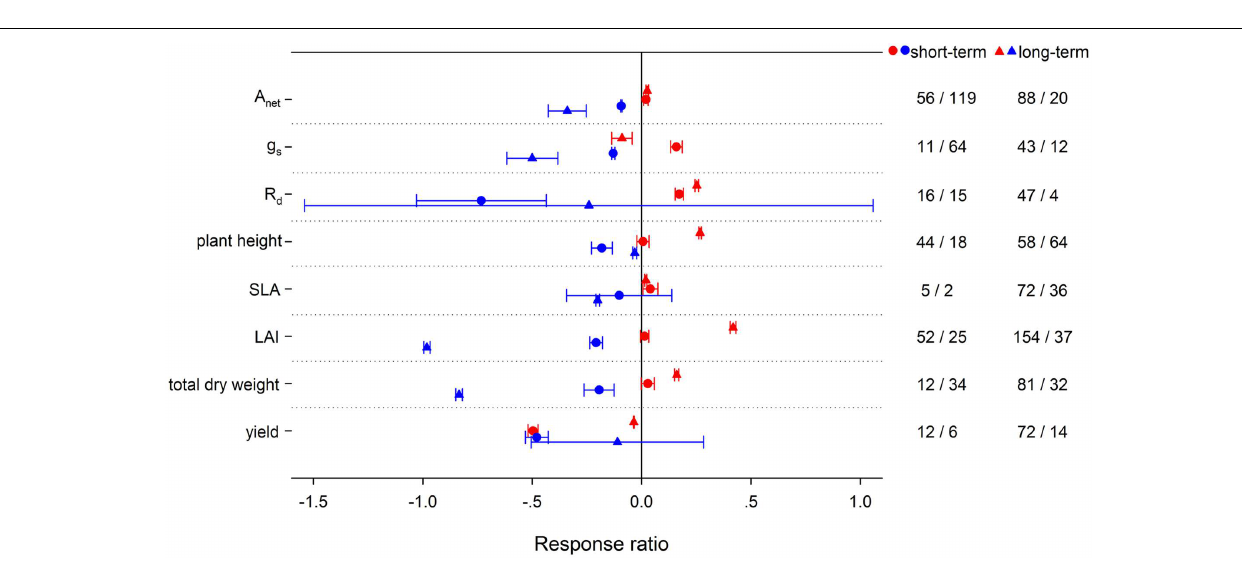
FIGURE 10 | Plant physiological, morphological and yield-related responses to HNT (red) and LNT (blue) grown in < 10 L pots (circles) or > 10L pots (triangles). Each data point represents the mean ± 95% CI. The number of observations for each variable is given on the right of the graph. Note that N is tissue nitrogen content including stem, leaf, panicle, spike, grain, shoot, root, and total N.